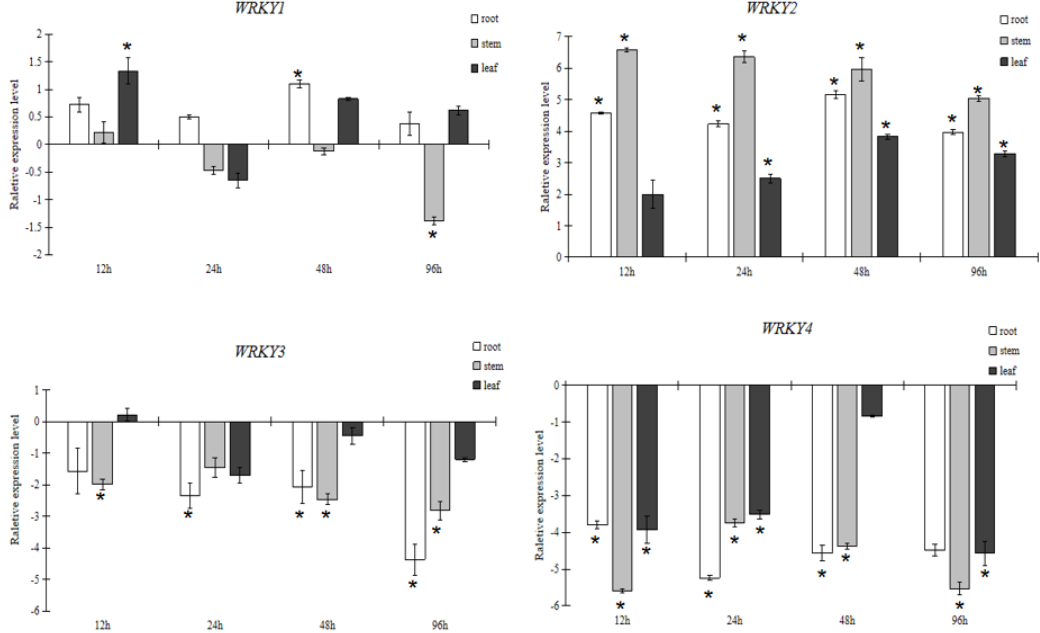
Figure 7. Gene expression levels at 0.1 mol/L NaHCO 3 solution treatment at different times. Note: * indicates a significant difference.